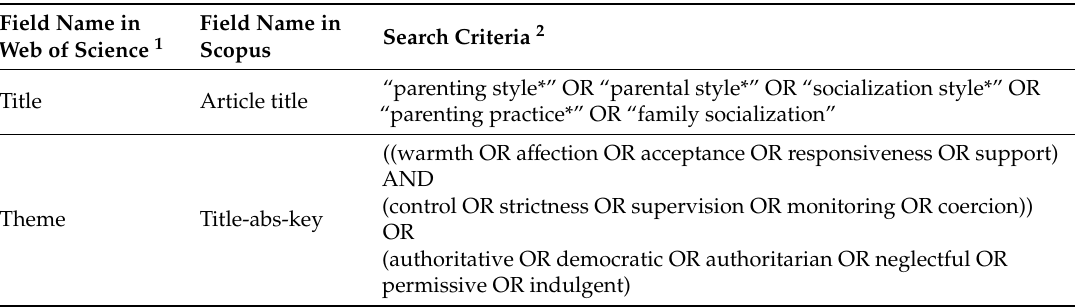
Table 1. Search criteria in the systematic